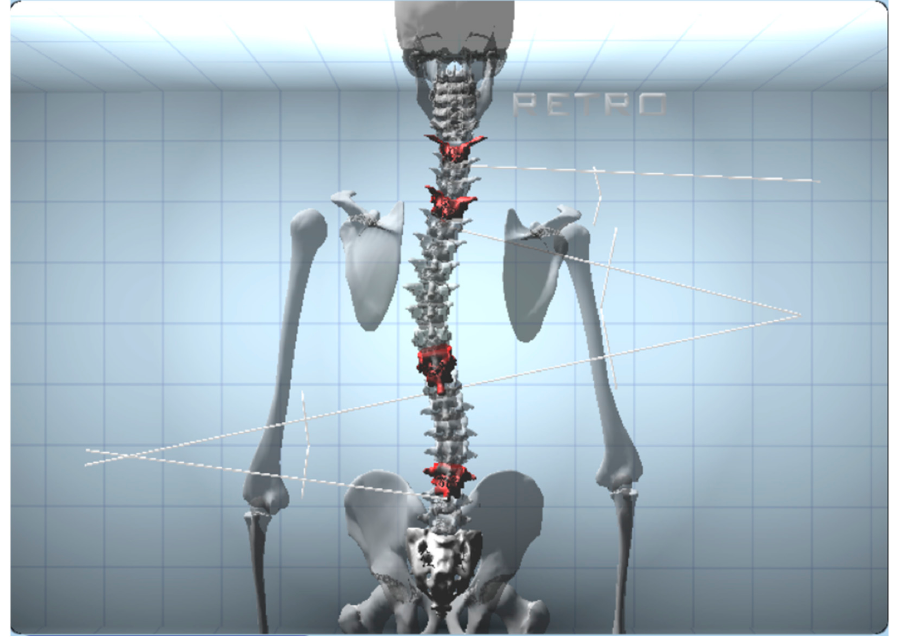
Figure 5. Three-dimensional BHOHB spine reconstruction.